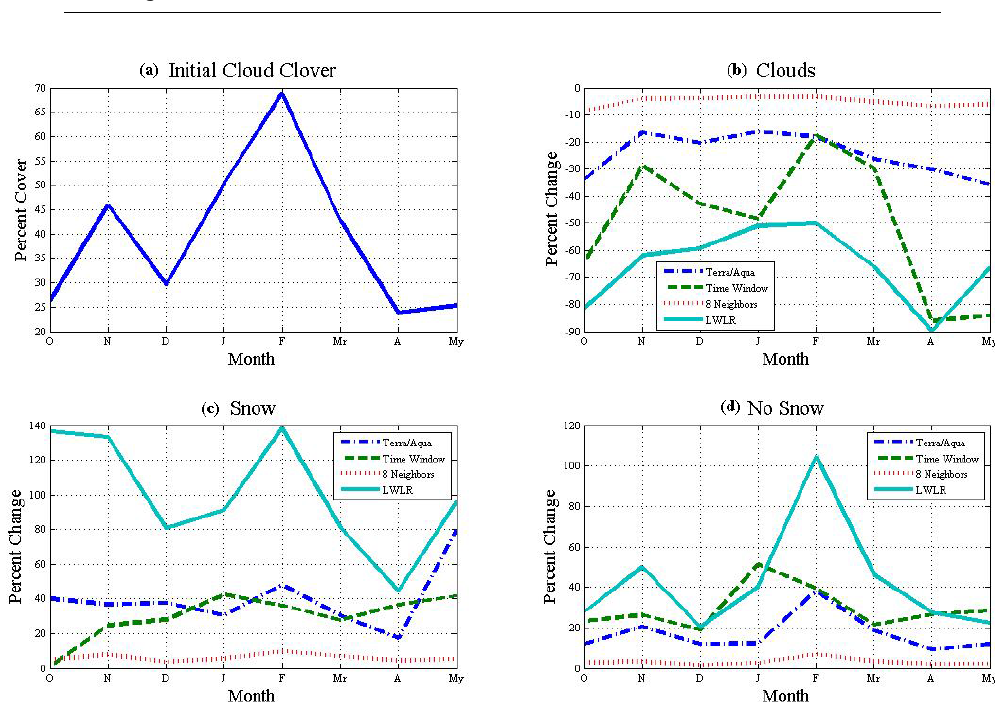
Fig. 5. (a) Shows how the percentage of pixels classified as cloudy in the original MODIS SCA images varies for each month during the study period; subplots (b) , (c) , and (d) show the corresponding percentage change in clouds, snow, and no snow achieved by each method for each